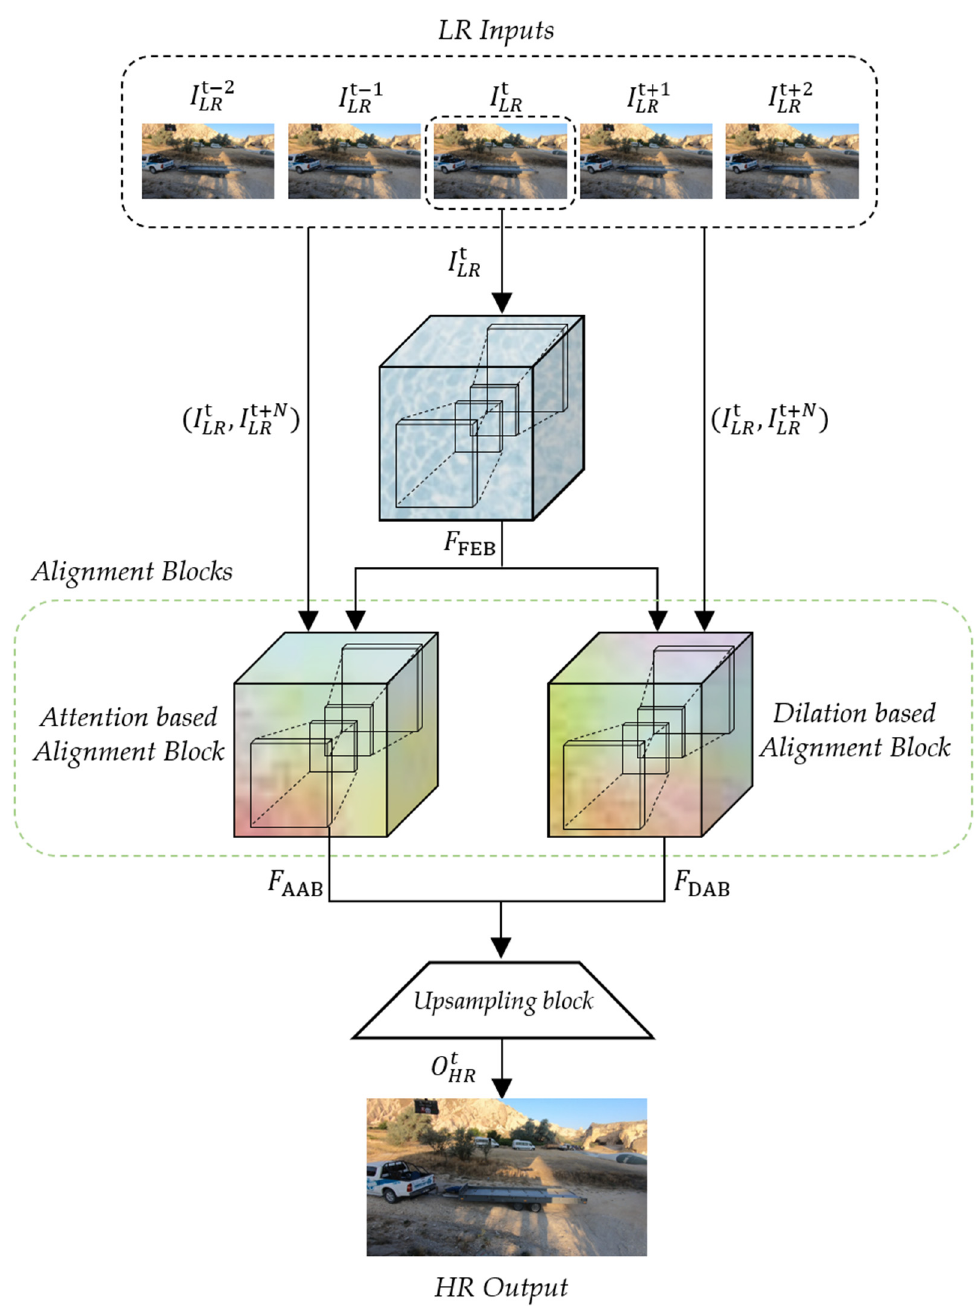
Figure 5. Overall architecture of the proposed